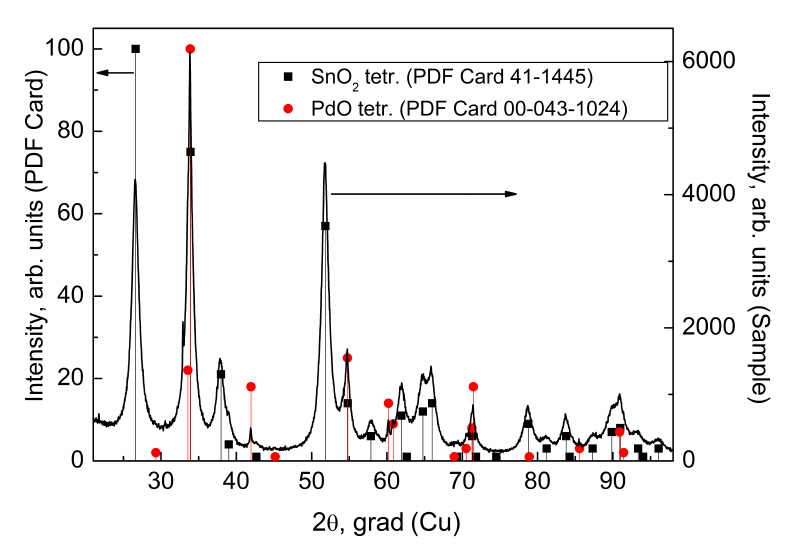
Figure 3. X-ray diffraction picture of the gas-sensitive layer.